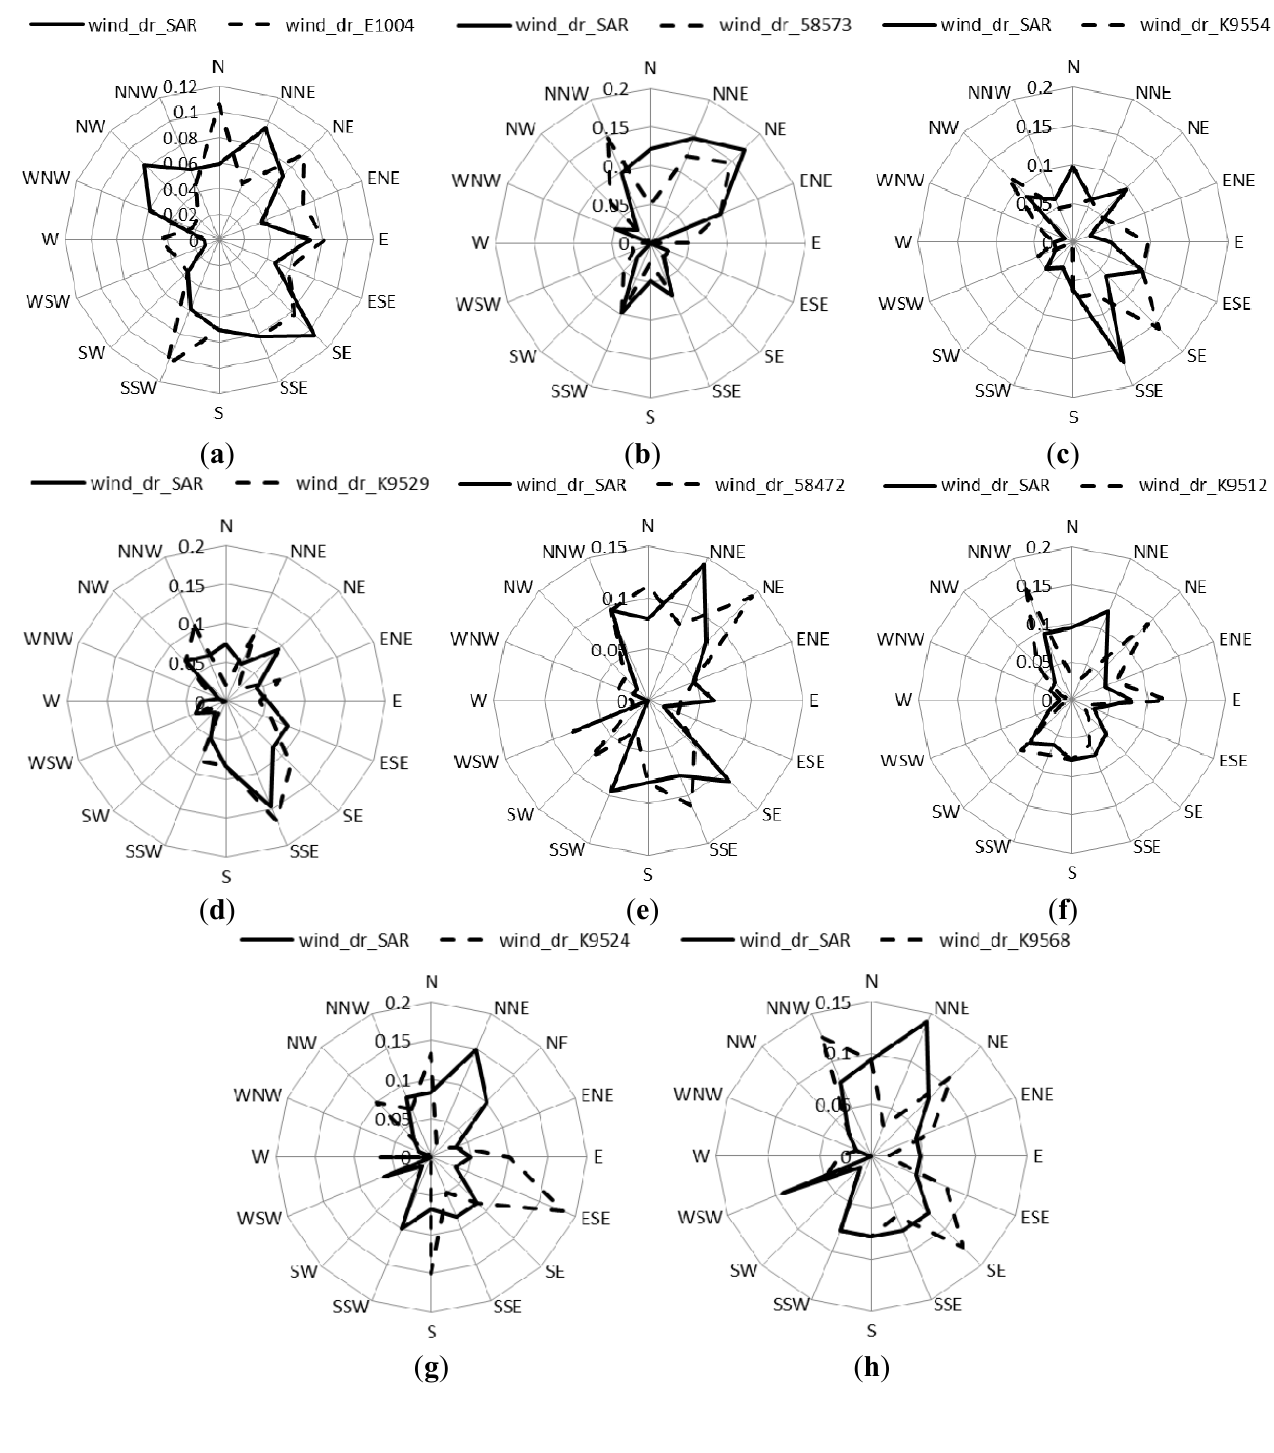
Figure 6. Directional distribution of winds from in situ mesurments (dashed lines) and from Navy Operational Global Atmospheric Prediction System (NOGAPS) (solid lines): ( a ) for E1004; ( b ) for 58573; ( c ) for K9554; ( d ) for K9529; ( e ) for 58472; ( f ) for K9512; ( g ) K9524; and ( h ) for